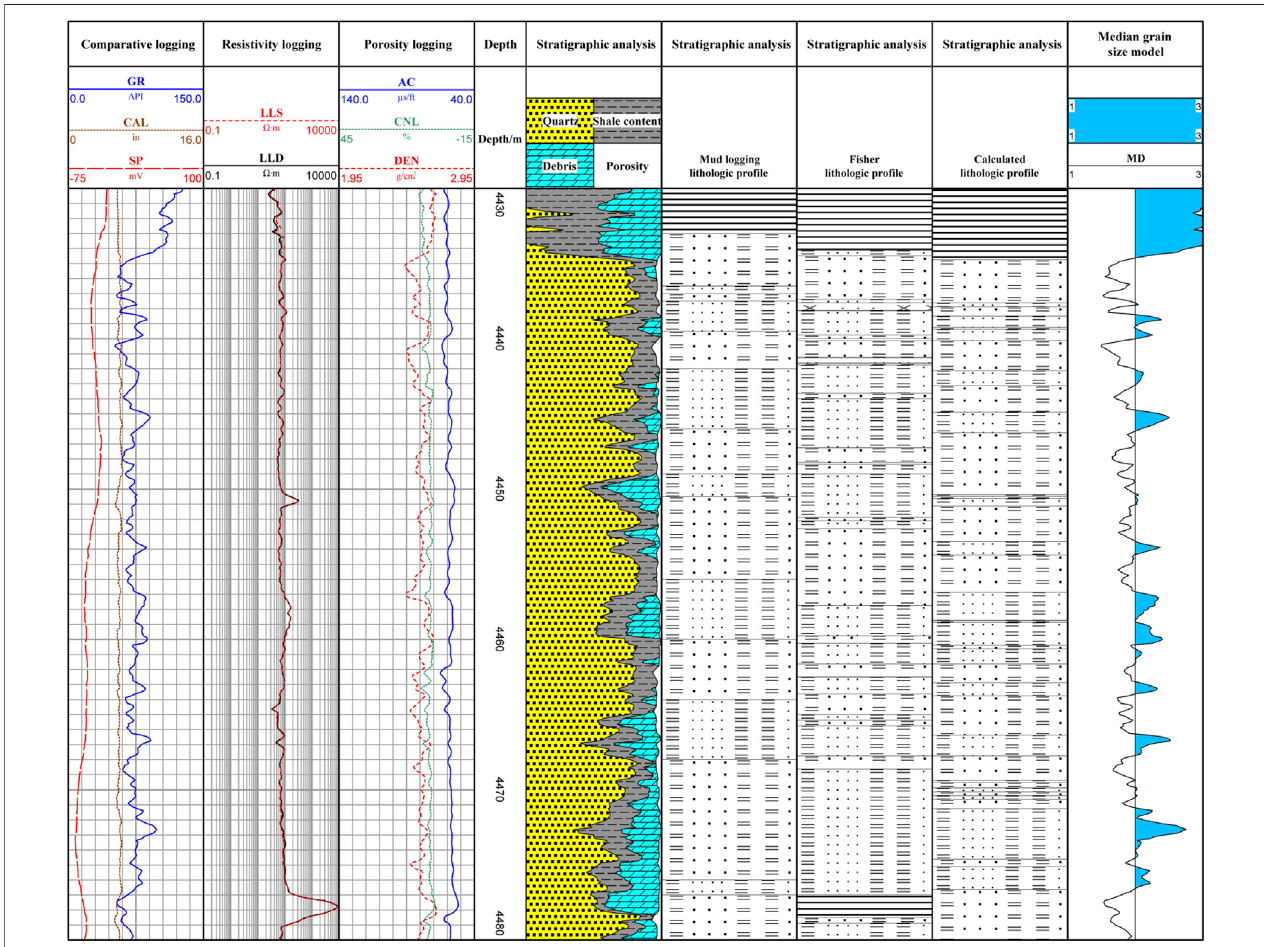
FIGURE 8 | Comparison of mud logging, Fisher discriminant, and the calculated lithological pro fi le of formation mineral composition at 4,430 – 4,480 m in well 1.